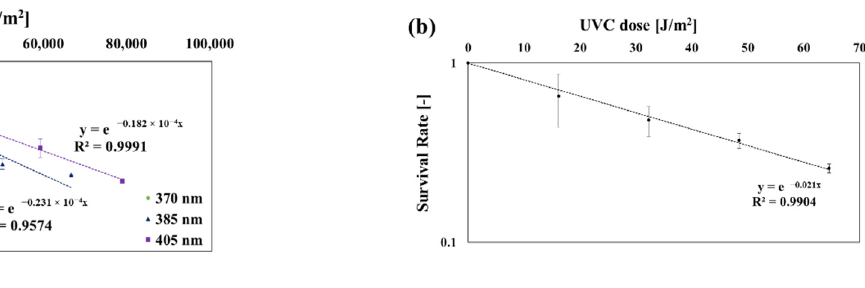
Figure 4. Inactivation curves of B. subtilis at each dose and wavelength: ( a ) 370, 385, and 405 nm; ( b ) 275 nm.